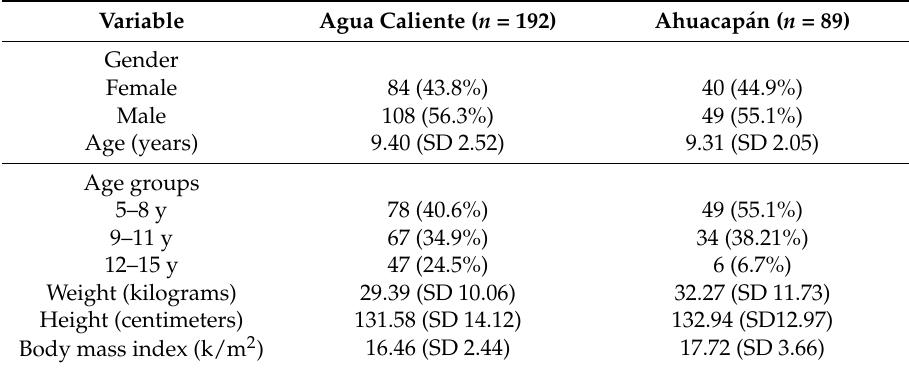
Table 3. Demographic and anthropometric data of the children in both communities. Variable Agua Caliente ( n = 192) Ahuacap á n ( n =